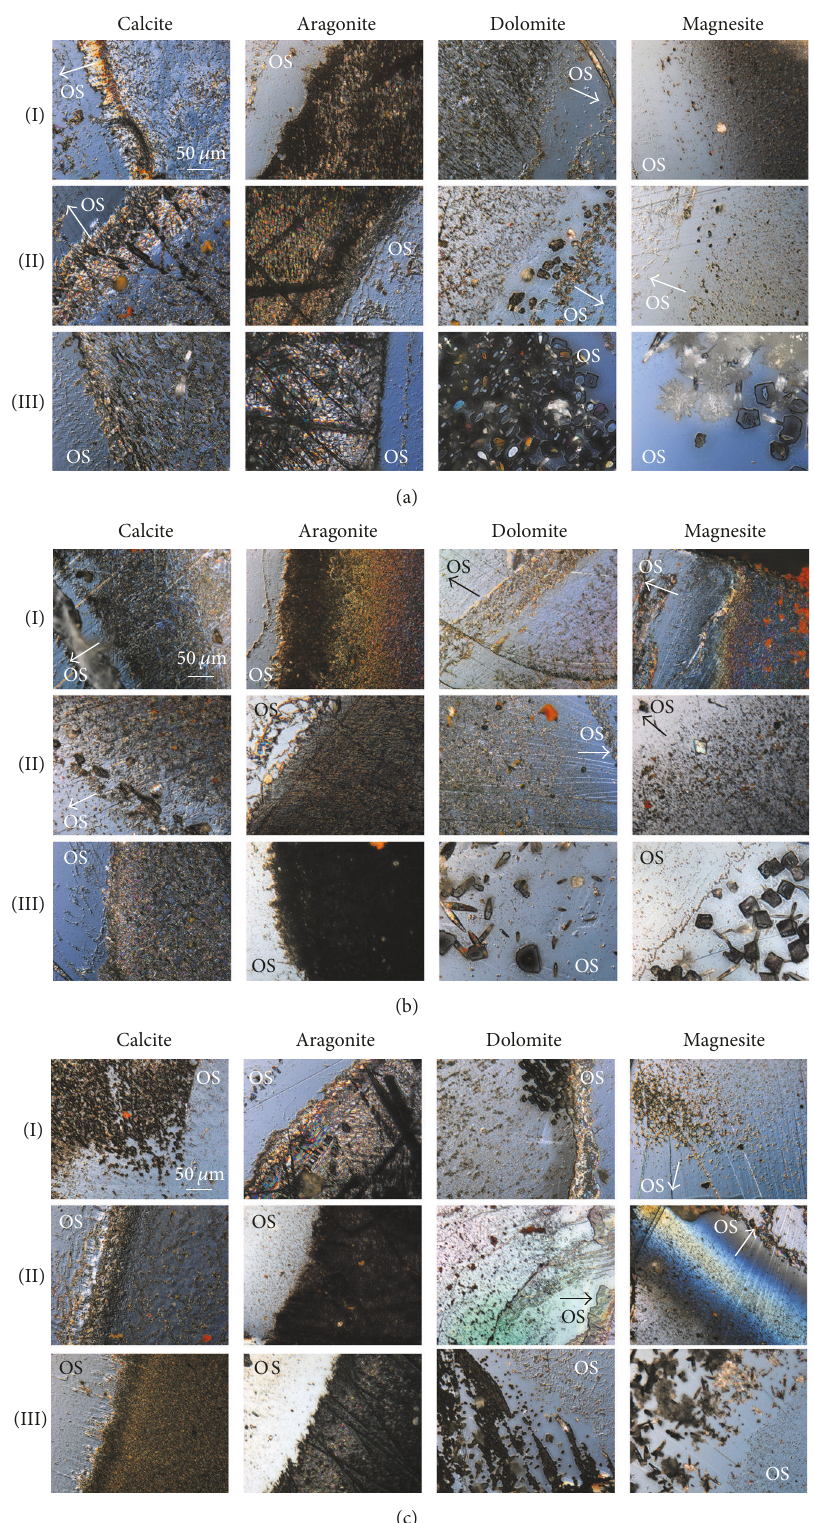
Figure 2: DIM images of sample surfaces: (a) after 21h in Run A, (b) after 22 h in Run B, and (c) after 23 h in Run C. Part of the original surface covered by a silicone rubber film during experiments is denoted as